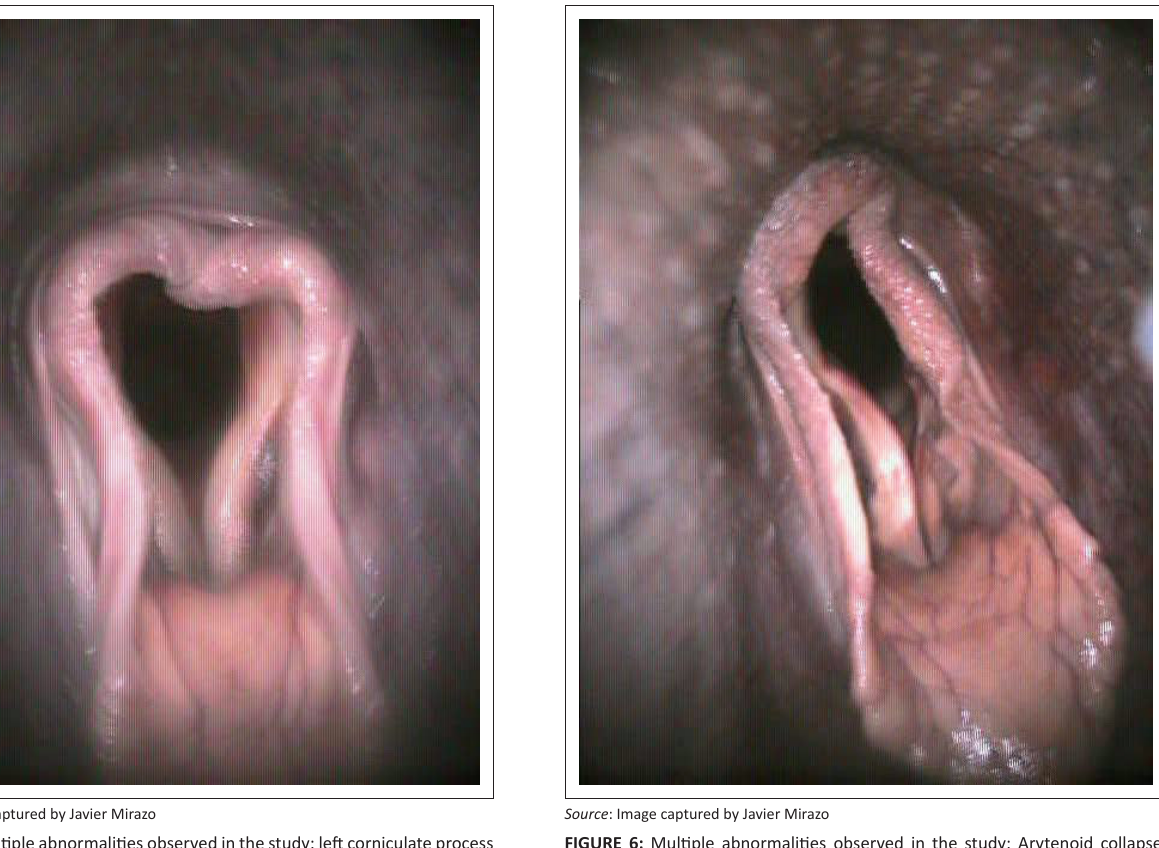
FIGURE 6: Multiple abnormalities observed in the study: Arytenoid collapse, vocal cord collapse and axial deviation of aryepiglottic folds.